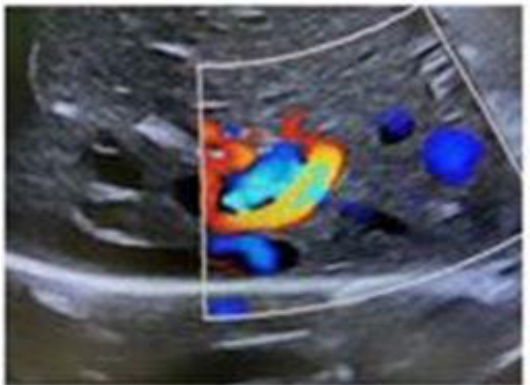
Fig. 2: Turbulent flow in the shunted vessel in PSS